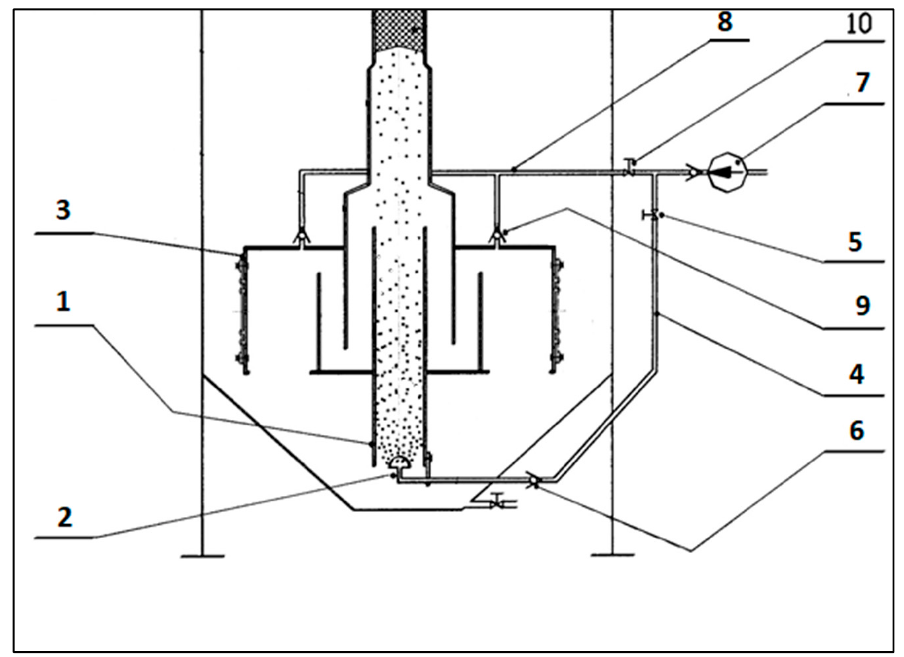
Figure 1. Diagram of the hybrid pump: 1—suction pipe, 2—diffuser, 3—working medium tanks closed from the top, 4—pipe, 5—control valve, 6—check valve, 7—compressor, 8—piping, 9—check valves, 10—control valve with compressor.